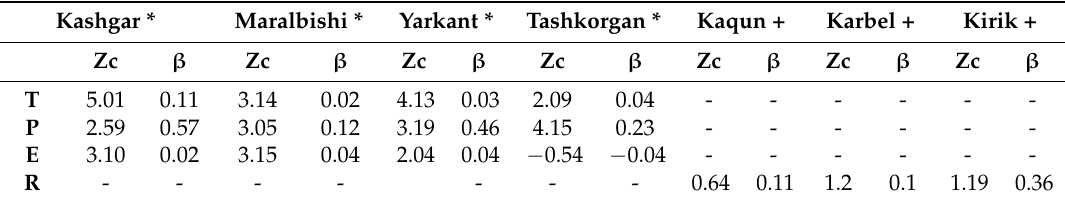
Table 6. The results of the Mann-Kendall test for climatic-hydro